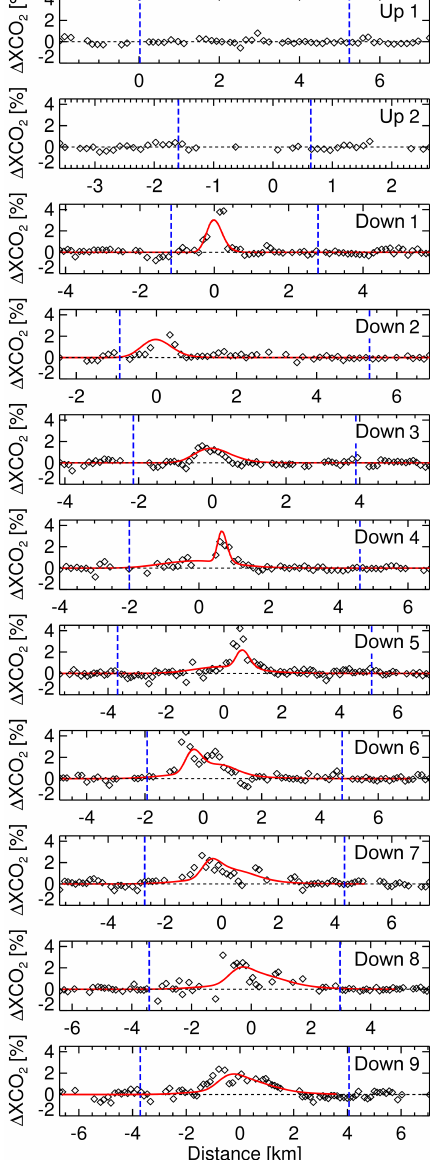
Figure 13. MAMAP XCO 2 transects for the tracks used for the emission rate estimates (black) and modelled Gaussian plume (red). The areas outside the dashed vertical lines denote the data that were used for the normalisation.